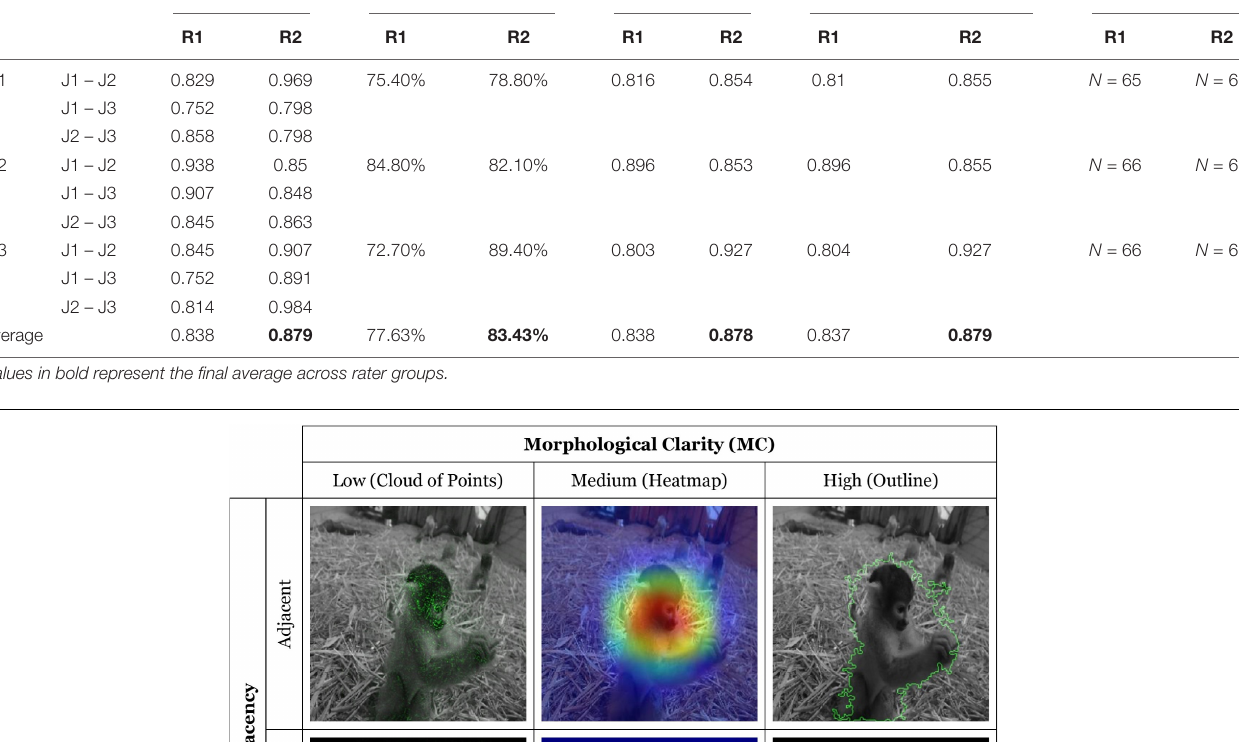
TABLE 1 | Overall inter-rater agreement for each group (G#) at each round (R#). Kappa Raw agreement Fleiss’s K